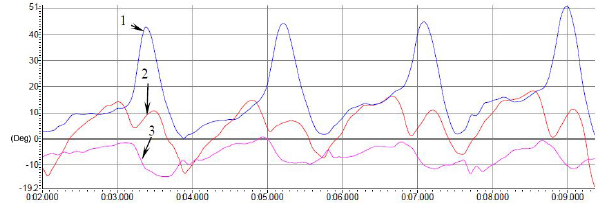
Figure 5. 1 – knee flexion/extension; 2 – hip flexion/extension; 3 – ankle flexion/extension; The experimental angles variations for dis- abled human, in sagittal plane, for right leg.